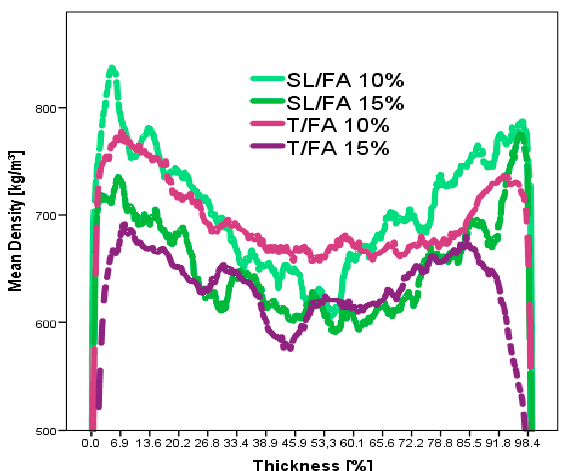
Figure 8. Particleboards: Spent-Liquor/Furfuryl alcohol with 10% and 15% of glue ( left side ) and Tannin-Furfuryl alcohol with 10% and 15% glue ( right side ).